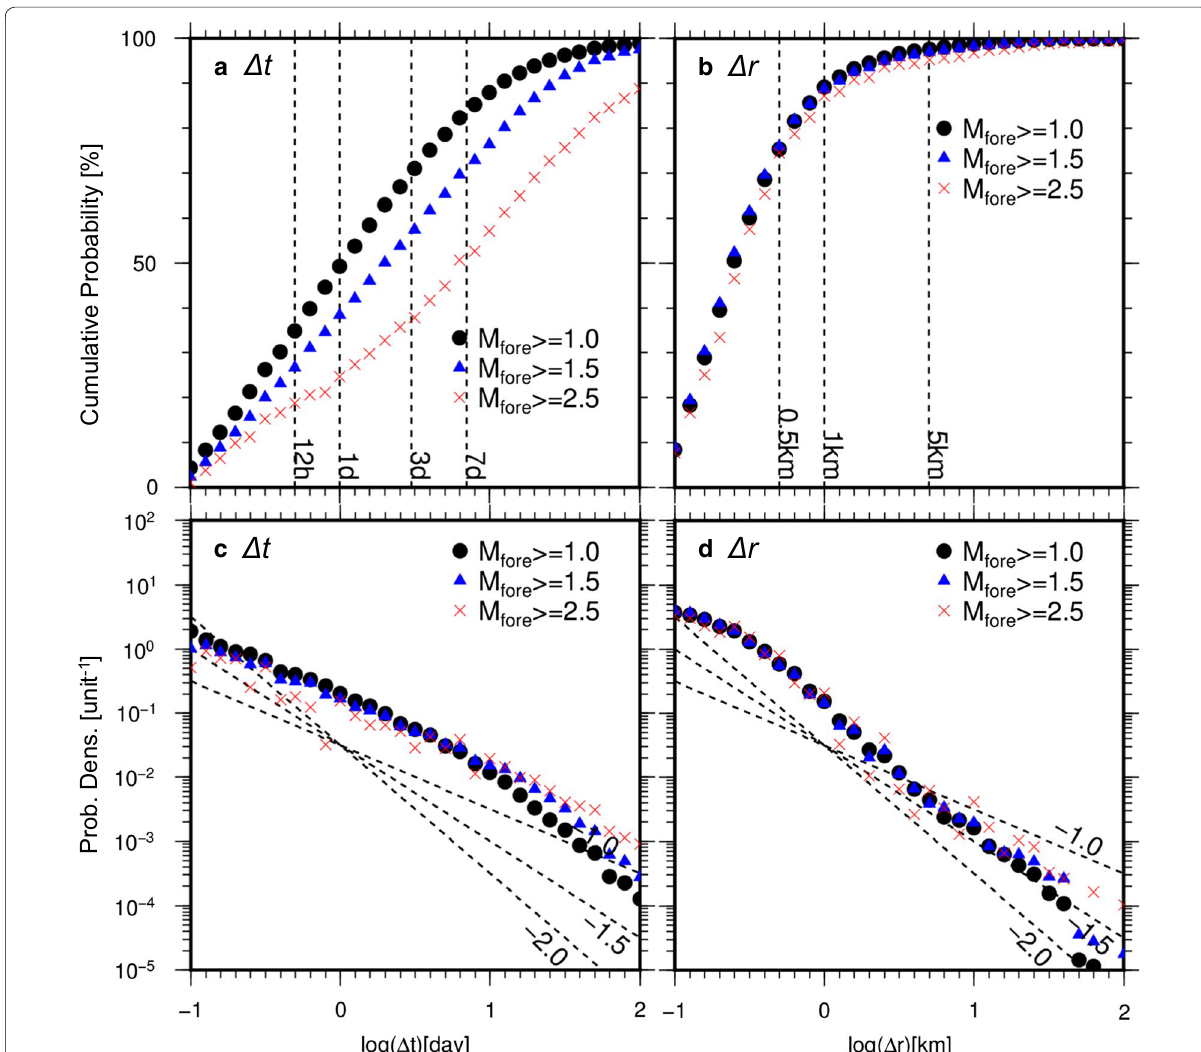
Fig. 7 Cumulative probability and frequency density distribution of the time difference ( (cid:31) t ) and the epicentral distance ( (cid:31) r ) between the largest foreshock and mainshock for long-term data. a , c Time difference ( (cid:31) t ) and b , d epicentral distance ( (cid:31) r ). a , b Cumulative probability distribution. b , d Probability density distribution. The dashed lines have slopes of and red crosses indicate that the magnitude of the largest foreshock is above 1.0, 1.5, and 2.5,